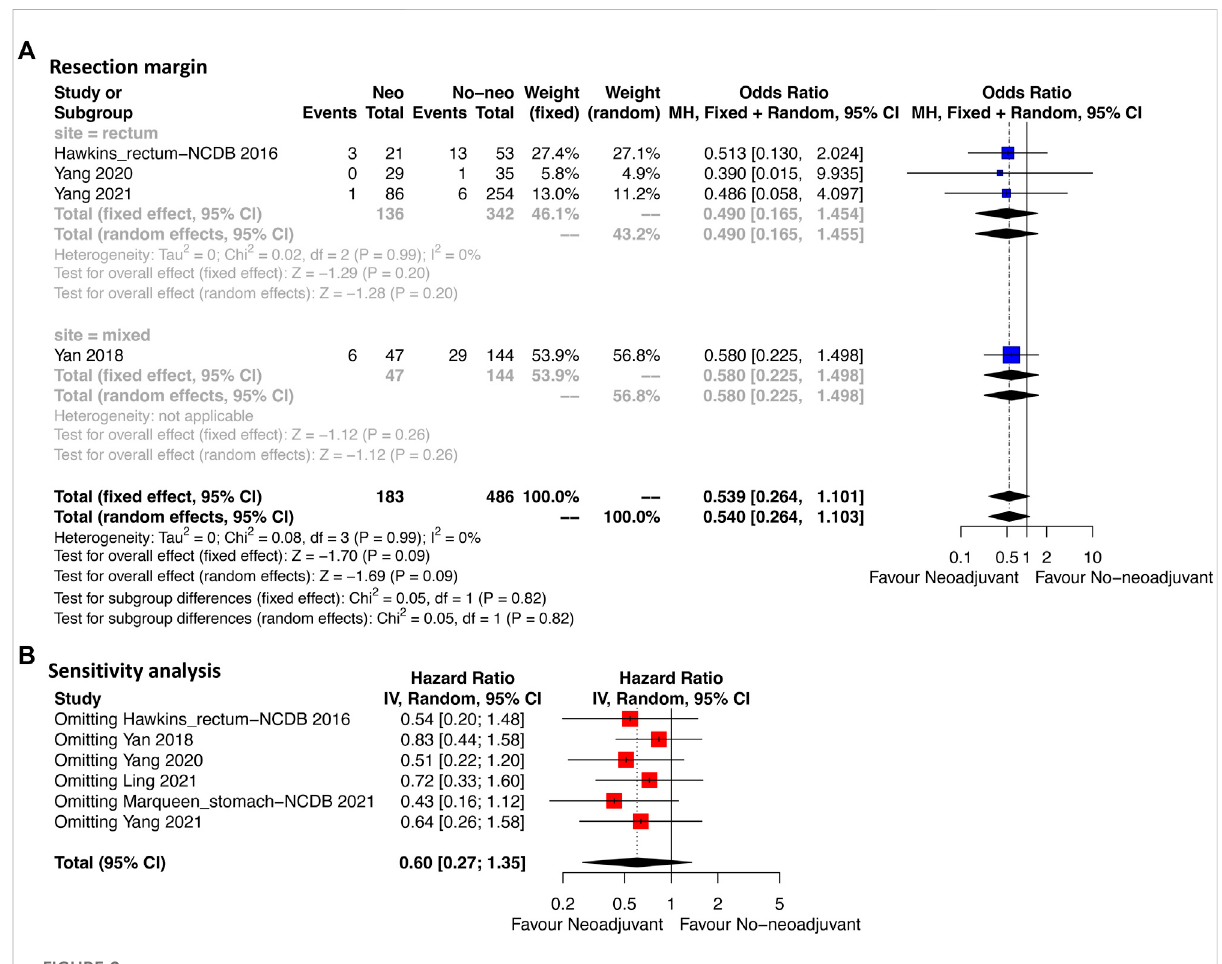
FIGURE 2 Forest plots illustrating resection margin between neoadjuvant and no-neoadjuvant imatinib (A) and sensitivity analysis (B)